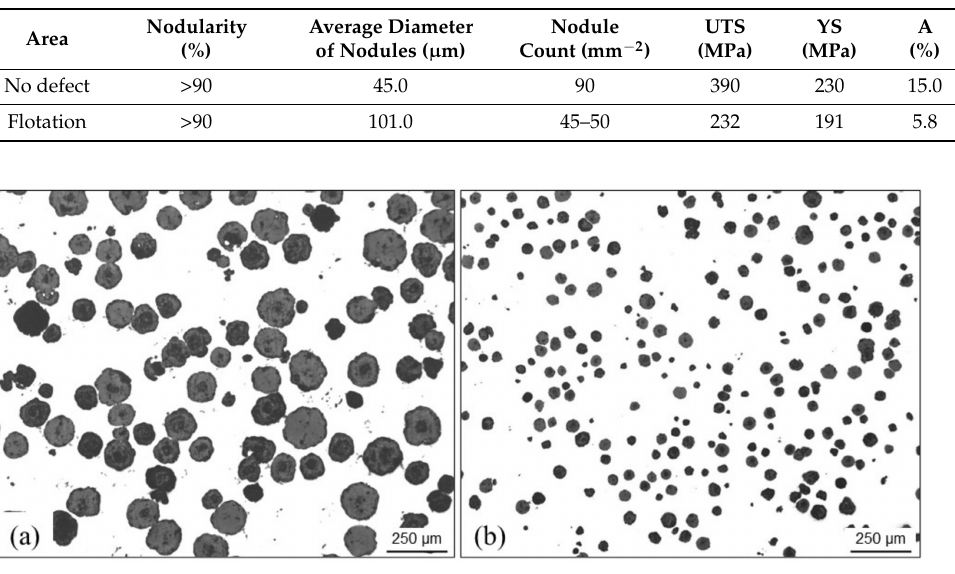
Figure 80. Distribution of graphite nodules present in ( a ) the area with graphite flotation and ( b ) the area without